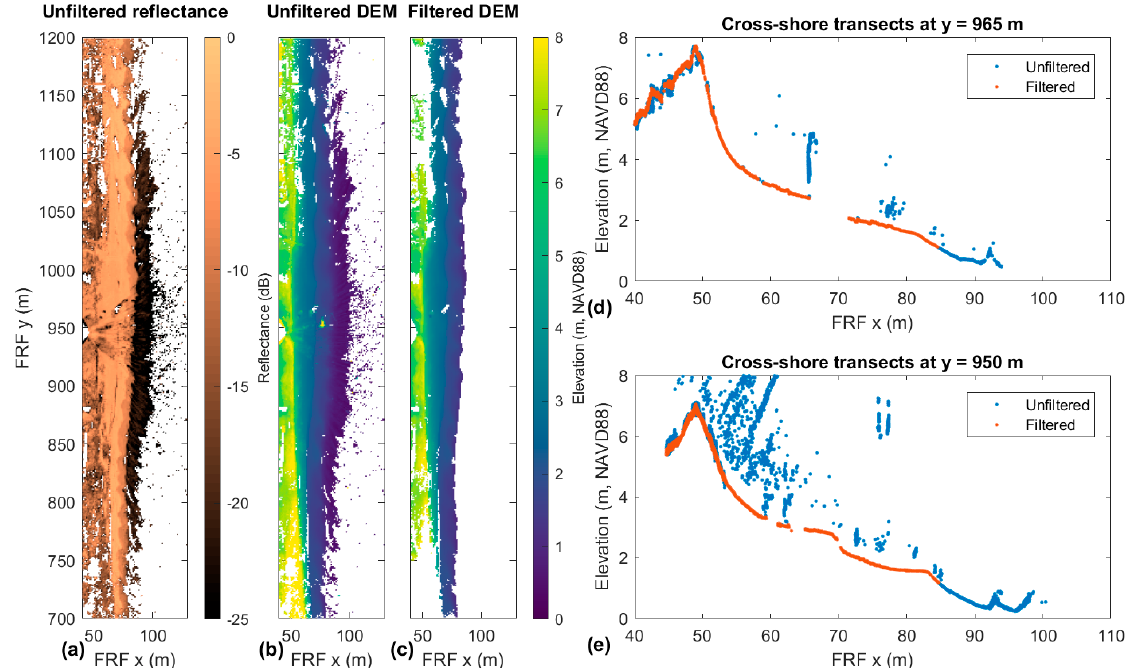
Figure 6. Example ( a ) unfiltered reflectance, ( b ) unfiltered DEM, and ( c ) filtered DEM from 18 September 2015 15:00 UTC, along with the cross-shore transects taken from the unfiltered and filtered framescans at ( d ) y = 965 m and ( e ) y = 950 m.